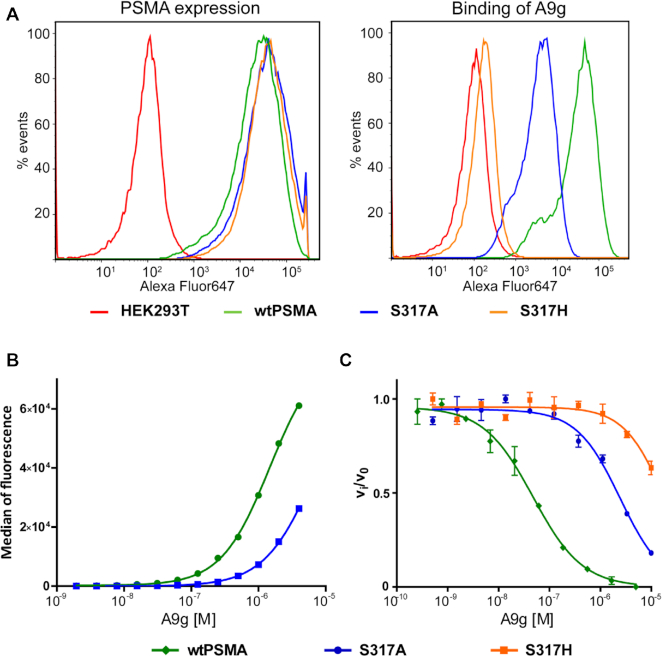
Effects of S317 mutations on PSMA/A9g interactions. (A, left) Flow cytometry analysis of expression levels of wtPSMA, and S317A and S317H mutants on the surface of transfected HEK293T/17 cells show comparable expression levels of all three PSMA variants. Cells were incubated with 40 nM 5D3 antibody and stained with Alexa Fluor647-conjugated goat anti-mouse secondary antibody. (A, right) Flow cytometry analysis of the A9g binding to HEK293T/17 cells expressing PSMA variants. Tested cell lines were labeled with 100 nM Alexa Fluor647-labeled A9g and analyzed by flow cytometry as described above. (B) Affinities of A9g toward wtPSMA and S317A cell lines. Dilution series of Alexa Fluor647-labeled A9g was incubated with transfected HEK293T/17 cells, analyzed by flow cytometry and median fluorescence plotted against A9g concentration. (C) Effect of S317 mutations on inhibitory potency of A9g. [3H]NAAG was used as a substrate and the cleaved product quantified by liquid scintillation. Three-fold dilution series of A9g were used to determine IC50 values against wild-type, S317A and S317H PSMA variants. The experiment was done in duplicate, and data are plotted as means ± standard error.